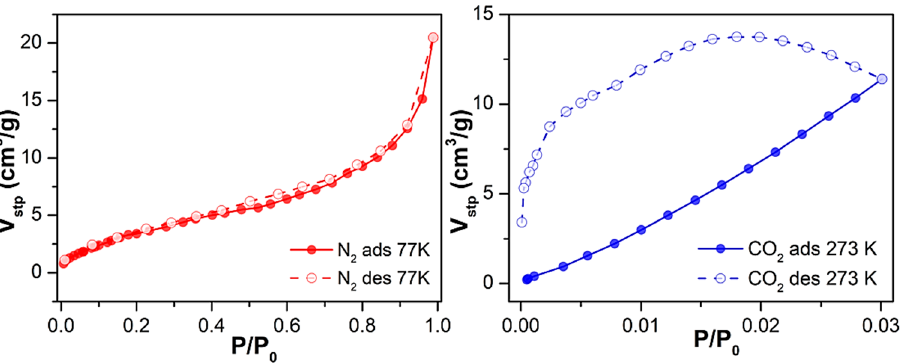
Figure 4. N 2 and CO 2 adsorption and desorption isotherms at 77 K and 273 K of 1 upon outgassing at 170 °C for 6 h after solvent exchange with EtOH.